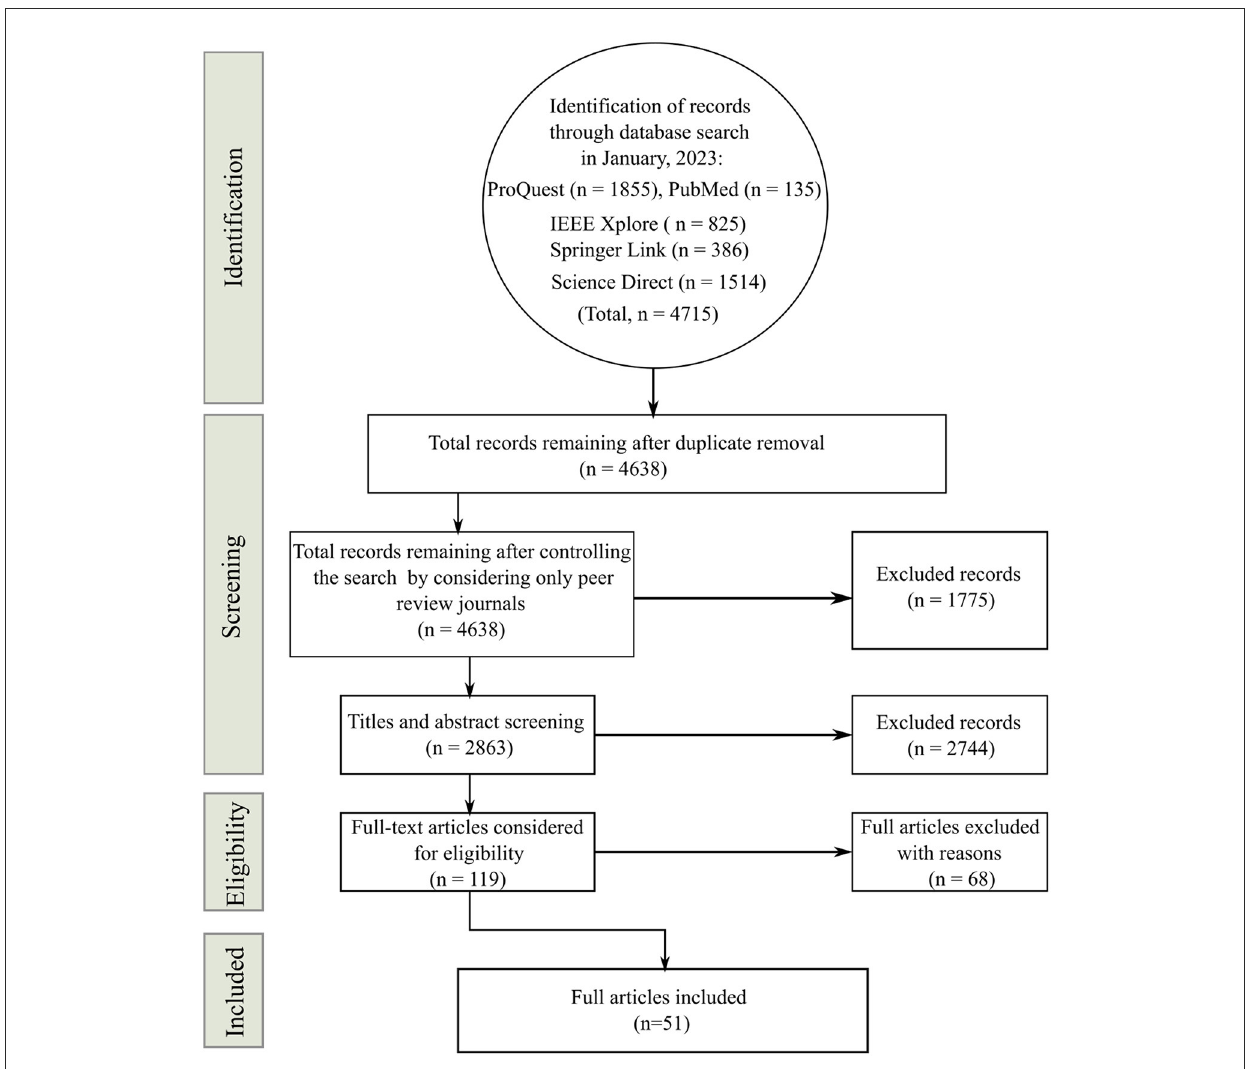
FIGURE1 Selection process and the methodology flow